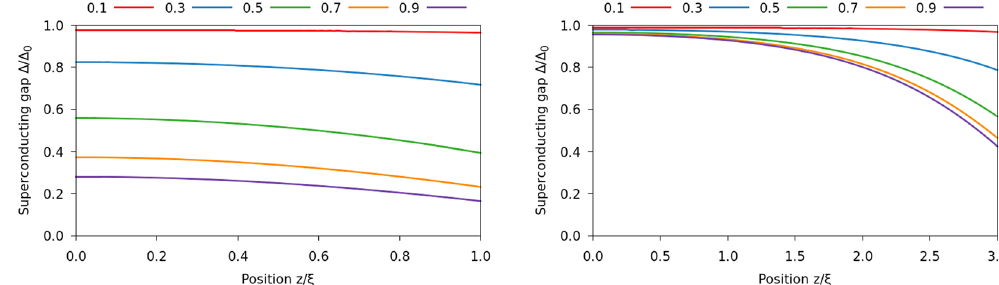
Figure 6. Plots of the superconducting gap in an S/FI bilayer. The superconductor has length L S = ξ S in the left plot and L